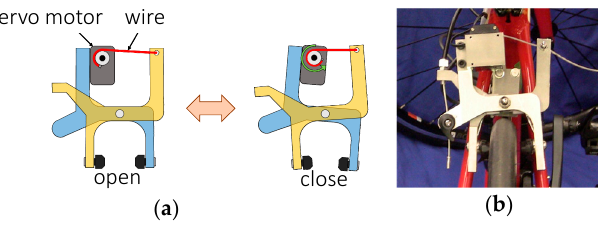
Figure 2. ( a ) The mechanism of the automatic speed control device; ( b ) A picture of the